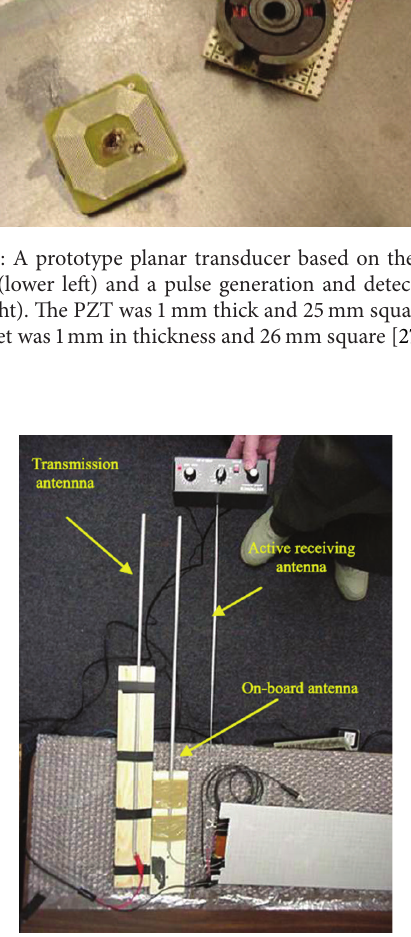
Figure 34: A wireless test setup